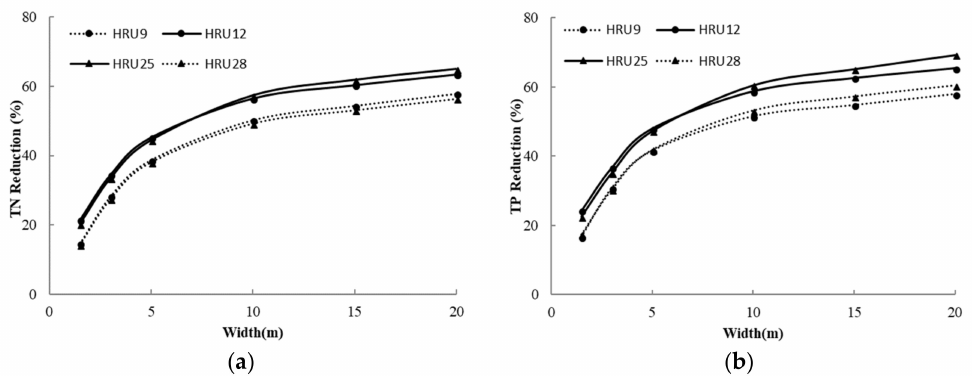
Figure 8. Relationships between nonpoint source pollution reduction e ffi ciency and bu ff er strip width for di ff erent HRUs. ( a ) Relationship between TN reduction and bu ff er strip width in HRU9, HRU12, HRU 25 and HRU28. ( b ) Relationship between TP reduction and bu ff er strip width in HRU9, HRU12, HRU 25 and